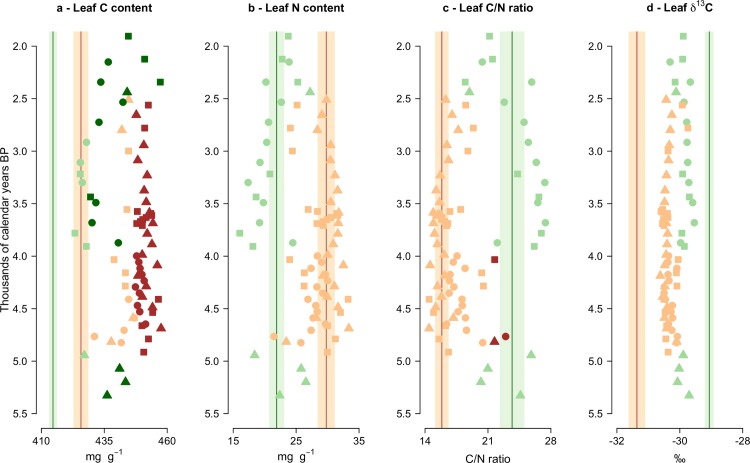
Changes in trait community weighted means (CWMs) through time (in thousands of calendar years before present) of the Holocene pollen-derived leaf trait records from three Romney Marsh sites (circles = Brookland; triangles = The Dowells; squares = Hope Farm).Green and brown symbols indicate the predominance of herbaceous and woody taxa in the Holocene record, respectively. The means of the modern vegetation (i.e., plant-based data) are shown for herb (green vertical lines) and woody (brown vertical lines) fens. Shaded areas around the modern means depict their 95% confidence intervals. Darker-coloured symbols show Holocene samples significantly different from their equivalent (herbaceous or woody) modern vegetation means at p < 0.05 (one-observation t-tests).